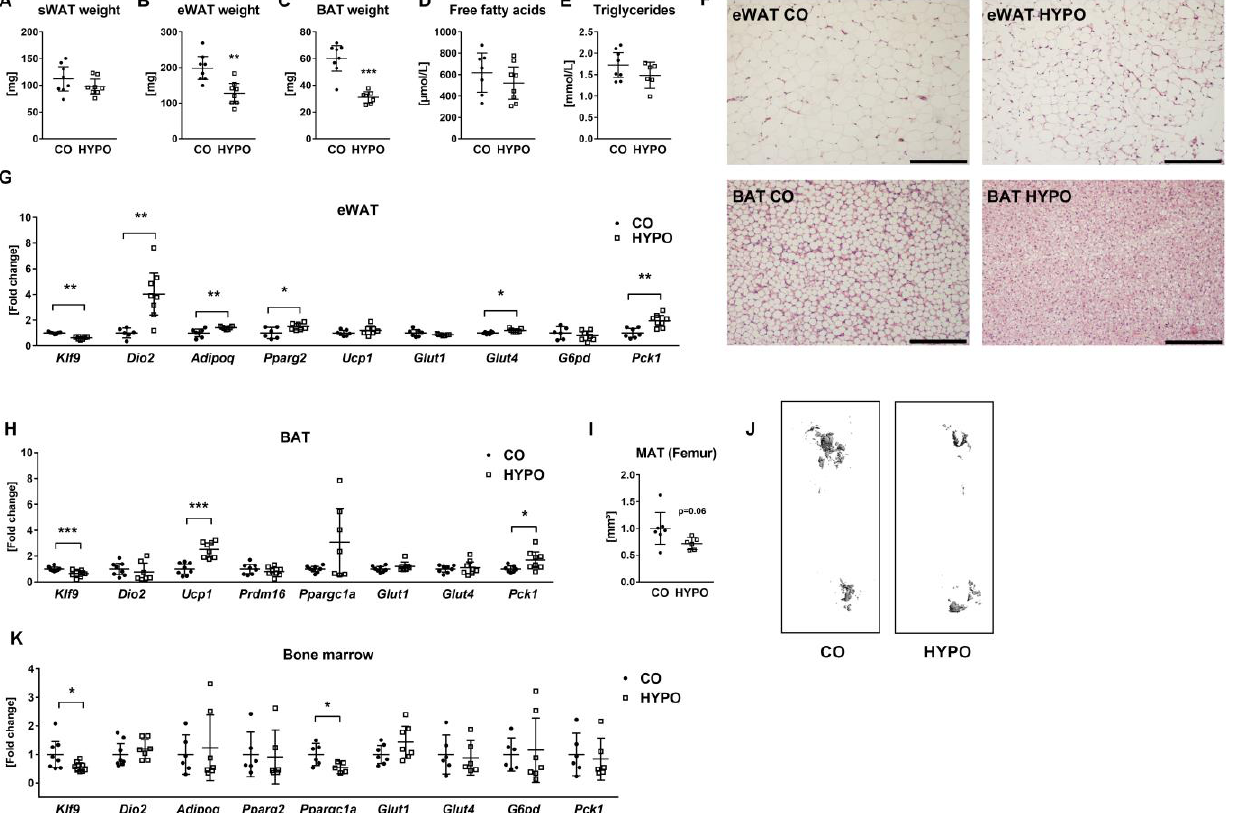
Figure 4. Lack of thyroid hormones results in reduced eWAT and BAT weights while increased white and brown adipocyte marker expression, respectively. Subcutaneous white adipose tissue (sWAT), epididymal white adipose tissue (eWAT), brown adipose tissue (BAT), and serum from 16- week-old male hypothyroid (HYPO) and control (CO) mice were collected and tested using Cobas 8000 modular analyzer, real-time PCR analysis, and histology. ( A ) sWAT, ( B ) eWAT, and ( C ) BAT were weighted postmortem. Levels of ( D ) free fatty acids and ( E ) triglycerides were measured in the serum. ( F ) Representative pictures of HE-stained eWAT and BAT sections from control and hy- pothyroid mice. Furthermore, ( G ) mRNA expression of Klf9 , Dio2 , adipocyte marker Adipoq and Pparg2 , and brown adipocyte marker Ucp1 , together with Glut1 , Glut4 , G6pd, and Pck1 was quanti- fied with real-time PCR analysis in eWAT. ( H ) Transcript levels of Klf9 , Dio2 , Ucp1 , Prdm16 , Ppargc1a , Glut1 , Glut4, and Pck1 were assessed in BAT from control and hypothyroid mice. Femurs from 16-week-old male hypothyroid and control mice were examined after osmium staining using microCT and ( I ) bone marrow adipose tissue volume (MAT) was quantified. ( J ) Representative pic- tures showing 3D reconstructions of MAT within femurs of control and hypothyroid mice. ( K ) mRNA expression of Klf9 , Dio2 , Adipoq , Pparg2 , Ppargc1a , Glut1 , Glut4 , G6pd, and Pck1 was measured using real-time PCR. Each dot indicates an individual mouse. The horizontal lines represent the mean ± 95% CI. Tissue weights and serum analyses: CO: N = 8, HYPO: N = 7; real-time PCR: CO: N = 7, HYPO: N = 8; Osmium staining: CO: N = 7, HYPO: N = 6. Statistical analysis was performed by Student’s t -test: * p < 0.05; ** p < 0.01; *** p < 0.001 vs. control. Using osmium staining, we detected a tendency for decreased bone marrow fat con- tent inside femurs of hypothyroid animals ( −2 8.41%, p = 0.06) and downregulated expres- sion of Klf9 and Ppargc1a , while transcript levels of the other selected genes were not al- tered, including glucose transporters and genes involved in glucose metabolism (Figure 4I – K). Overall, we found tissue-specific effects of hypothyroidism on local glucose metabo- lism either affecting glucose uptake, gluconeogenesis, and/or cellular activity, suggesting